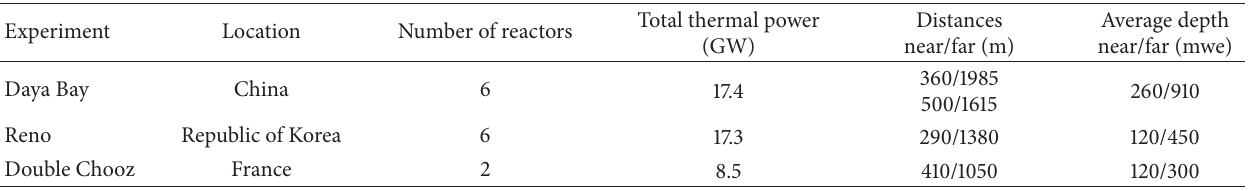
Table 1: Nuclear reactor experiments Daya Bay, Reno, and Double Chooz. For each experiment the location, the number of nuclear reactors, the overall thermal power, the near/far detector distances, and the approximate depth of near/far detectors are given. Note that Daya Bay has two separate reactor core sites and therefore two near/far distances.